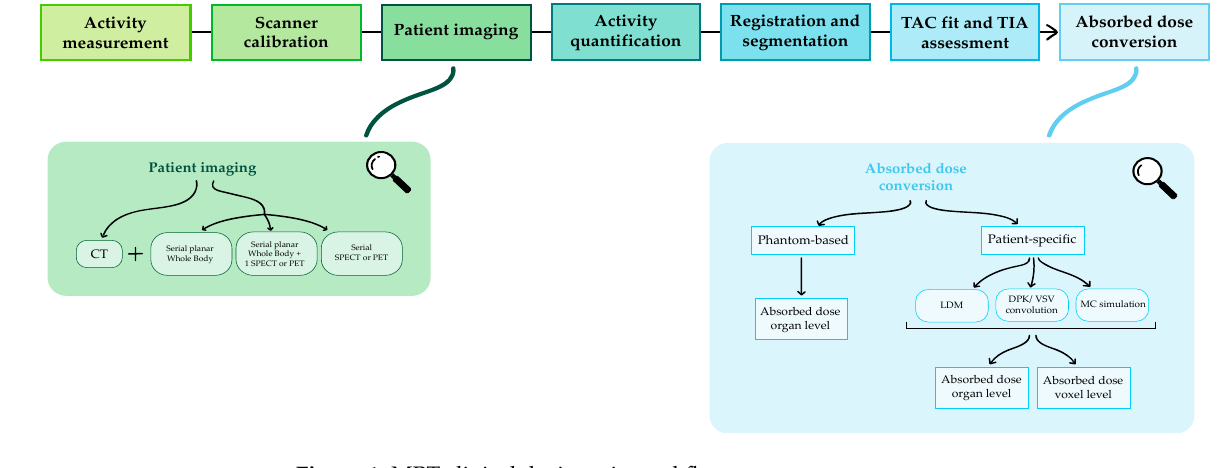
Figure 1. MRT clinical dosimetric workflow.